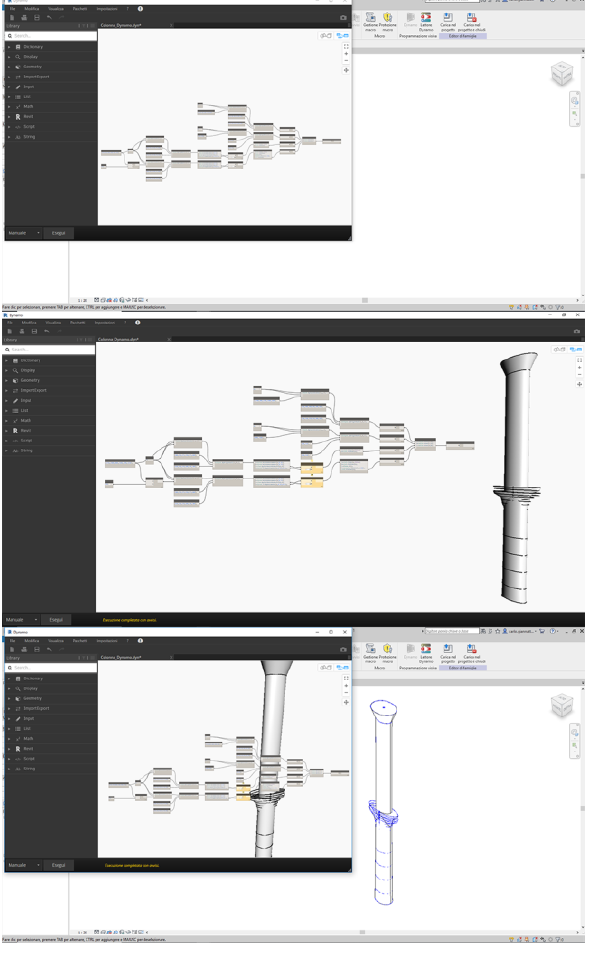
Figure 5. Functioning of the modelling algorithm. On the top, process start. On the centre, processing phase. On the bottom, final phase and results.